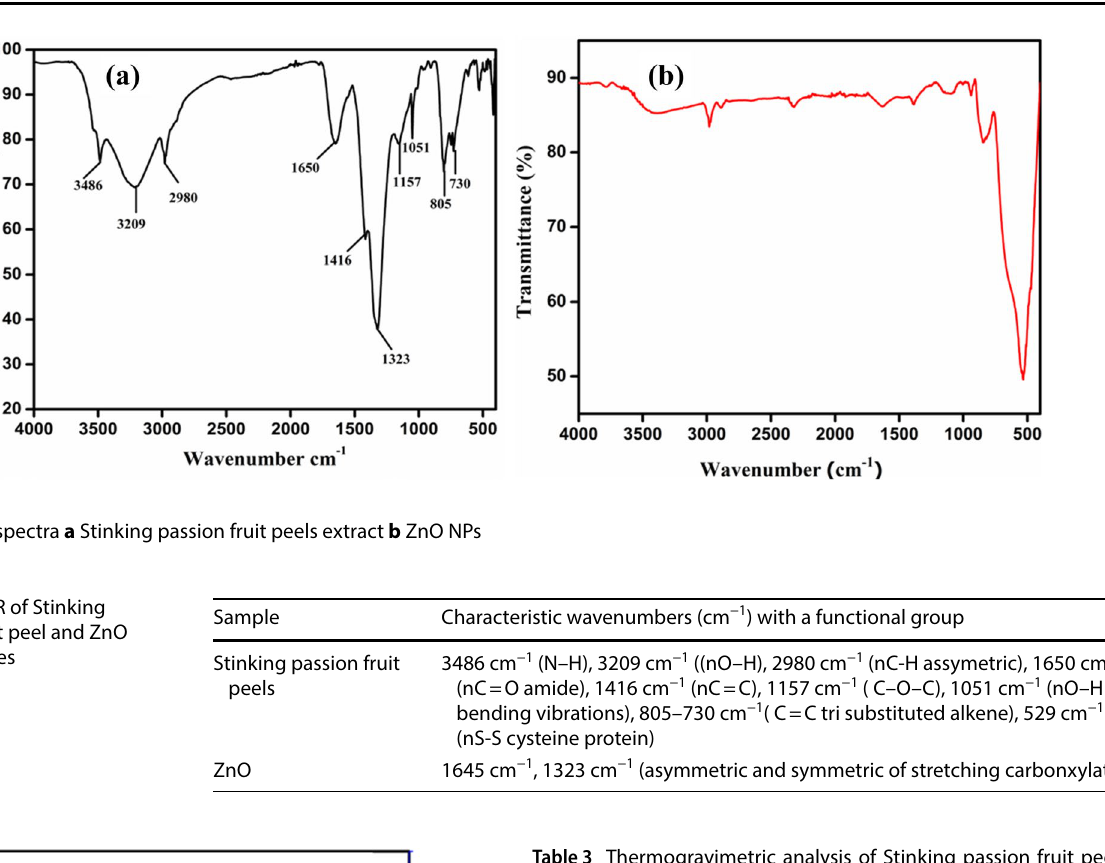
Table 3 Thermogravimetric analysis of Stinking passion fruit peels extract and derived ZnO NPs